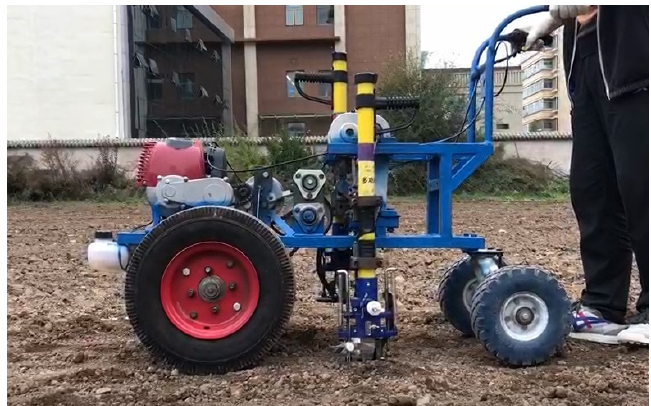
Figure 22. 2BZ-2 type cavity planter with vertical